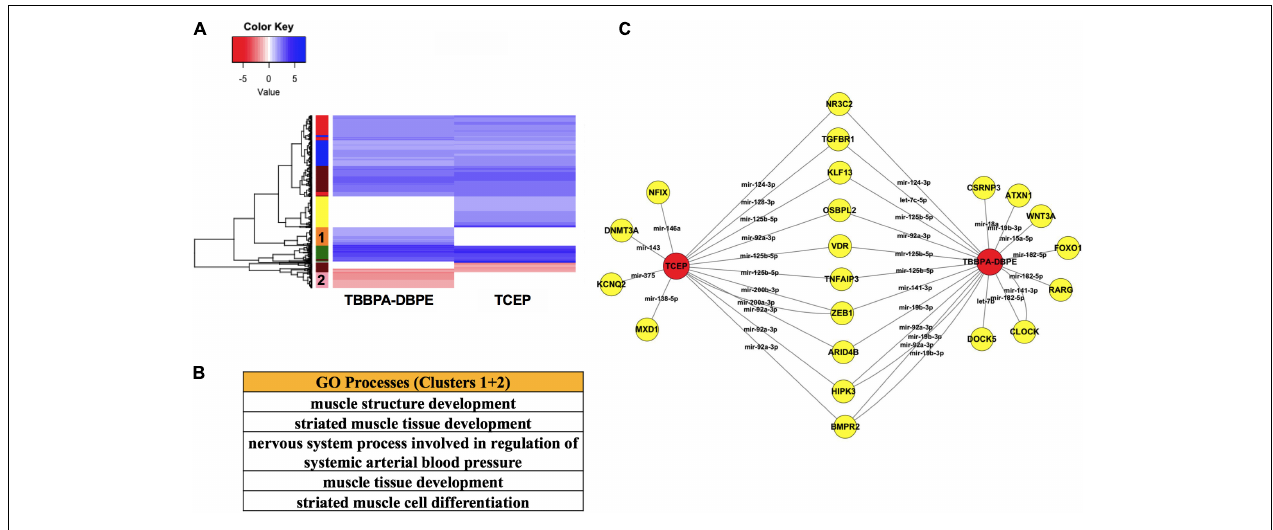
FIGURE 6 | Comparison of TBBPA-DBPE and TCEP for neurotoxic effects. TBBPA-DBPE exposures showed only LPR phenotypes while TCEP showed no phenotype. (A) Heatmap representing mRNA expression for the two FRCs; colored bars on the rows represent gene clusters. (B) GO processes for unique differential mRNAs with increased (Cluster 1) and decreased (Cluster 2) in the TBBPA-DBPE exposures. (C) mRNA-miR network for the two FRCs. • FRC, • genes. miRs are represented within connected